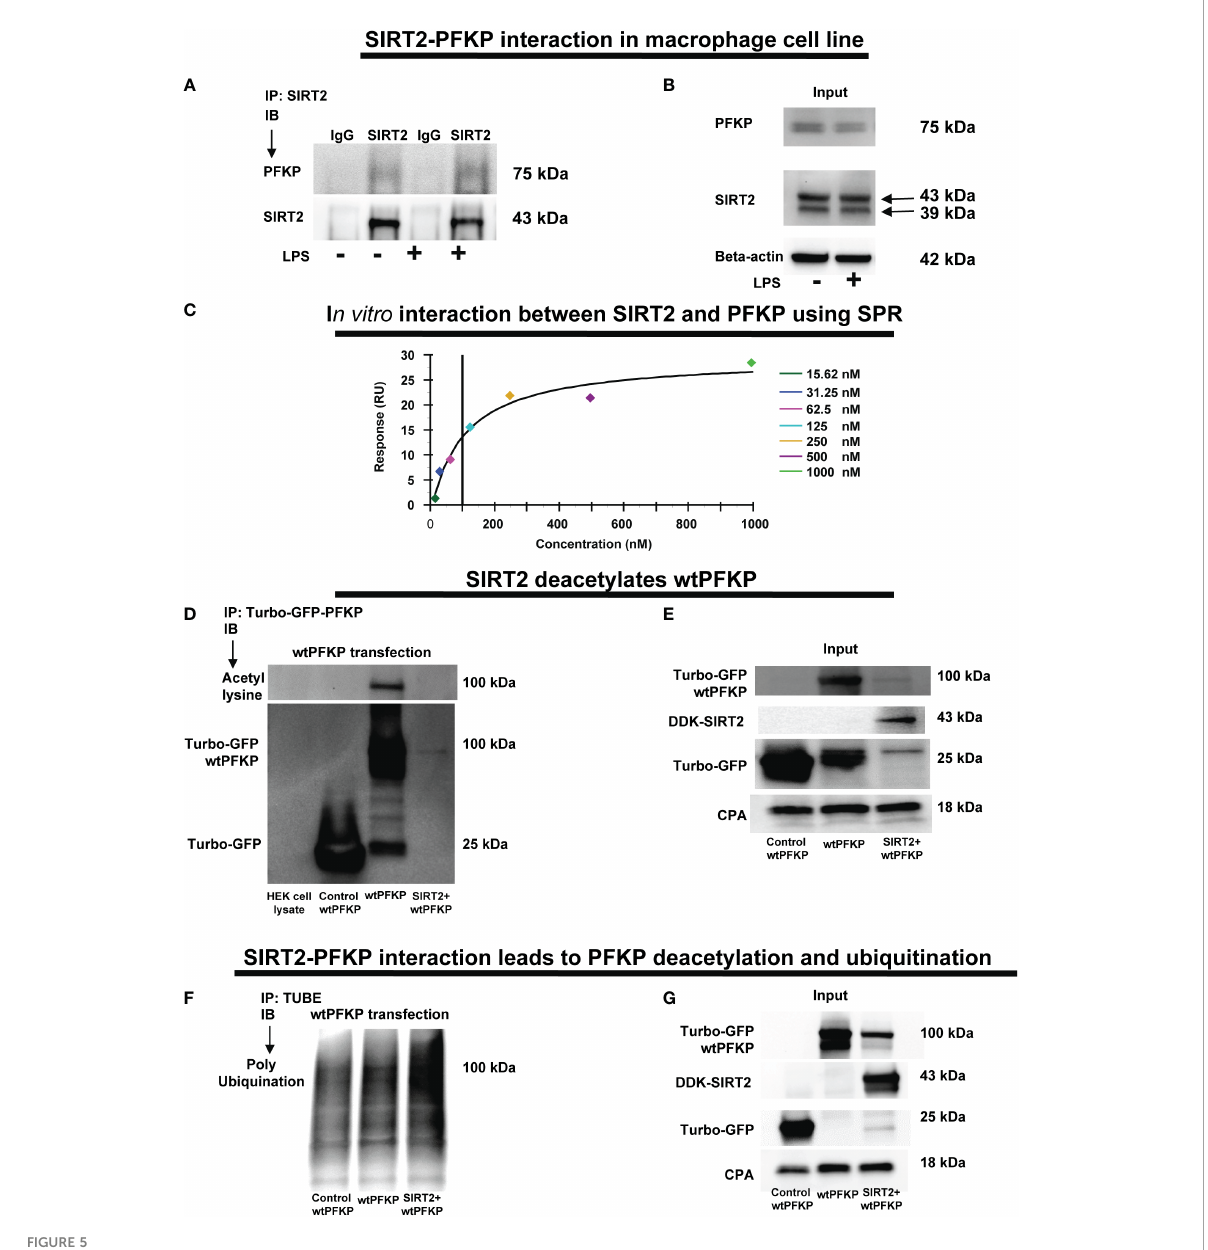
FIGURE 5 SIRT2-PFKP in vivo and in vitro interaction. (A) RAW264.7 cell macrophages (RAW) ± LPS. IP of whole-cell lysates using an anti-SIRT2 antibody followed by IB analysis of PFKP and SIRT2. IP with isotype IgG control antibody was used as a negative control. (B) Western blot analysis of PFKP and SIRT2 in the whole cell lysate used as input for the SIRT2 IP. (C) In-vitro interaction between SIRT2 and PFKP using SPR. SIRT2 protein immobilized onto sensor chip and the PFKP was fl owed at various concentration (15.62, 31.25, 62.5, 125, 250, 500 and 1000nM). The response units on Y axis (RU) represent quantitative assessment of protein-protein interaction. (D) wtPFKP and control plasmid transfection and IP, using turbo-GFP-trap in HEK293T cells, in presence or absence of SIRT2 followed by IB analysis of acetyl lysine, turbo-GFP-wtPFKP and control for PFKP (turbo-GFP). HEK293T cell lysate without transfection used as a negative control. (E) Western blot analysis of control-PFKP (Turbo-GFP), wtPFKP (Turbo-GFP-wtPFKP), DDK-SIRT2 and CPA in whole cell lysate used as input for the turbo-GFP IP. (F) wtPFKP transfection and IP using magnetic-TUBEs in HEK293T cells, in presence or absence of SIRT2 followed by IB analysis of ubiquitination. (G) Western blot analysis of turbo- GFP wtPFKP, DDK-SIRT2, turbo-GFP and CPA in whole cell lysate used as an input for the TUBE